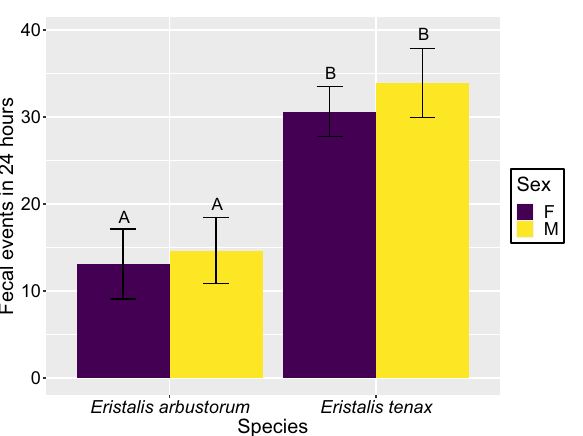
Figure 3. Number of fecal events by Eristalis arbustorum and E. tenax flies over 24 h. Different letters indicate post-hoc significance ( p < 0.05), error bars indicate 95% confidence